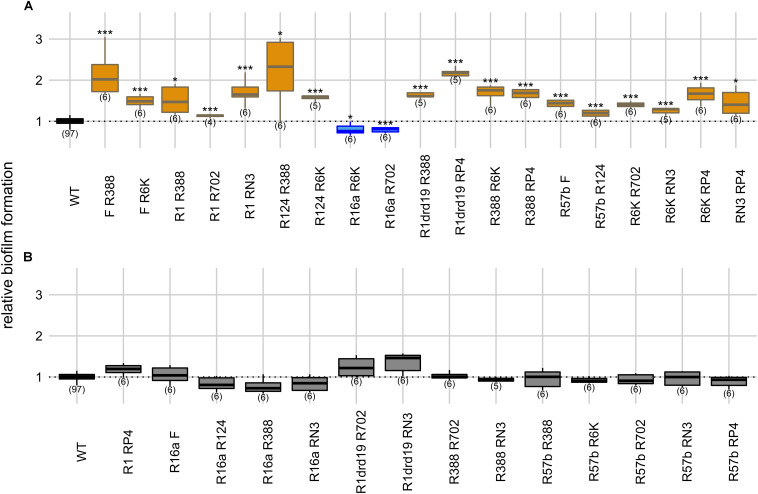
Intracellular effects of two plasmids on biofilm formation. Panels indicate significant (A) and non-significant effects (B) on biofilm formation relatively to the plasmid-free strain. Y axis represents biofilm formation relative to the plasmid-free strain (WT). Plasmid combinations are indicated in the x axis and the number of biological replicates below the boxes (in parenthesis). Results of Dunnett’s multiple comparison test against the plasmid-free strain are indicated as: *p-value < 0.05; **p-value < 0.01; ***p-value < 0.001. Box color, as in Figure 1, indicates the phenotype qualitatively, such that biofilm formation: increased significantly (orange), decreased significantly (blue), or did not change significantly (light gray in panel B). Dark gray indicates the plasmid-free reference strain (WT).